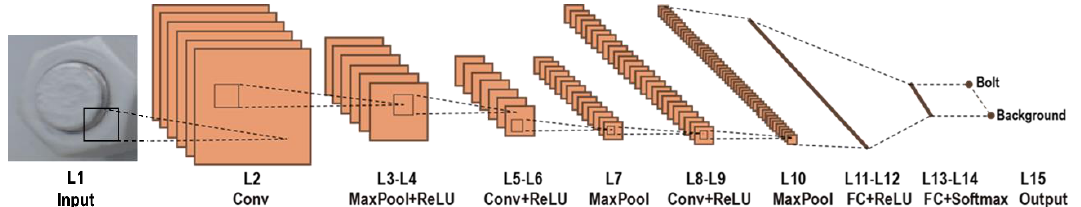
Figure 3. The overall structure of the bolt classifier consisting of 15 convolutional neural network (CNN) layers